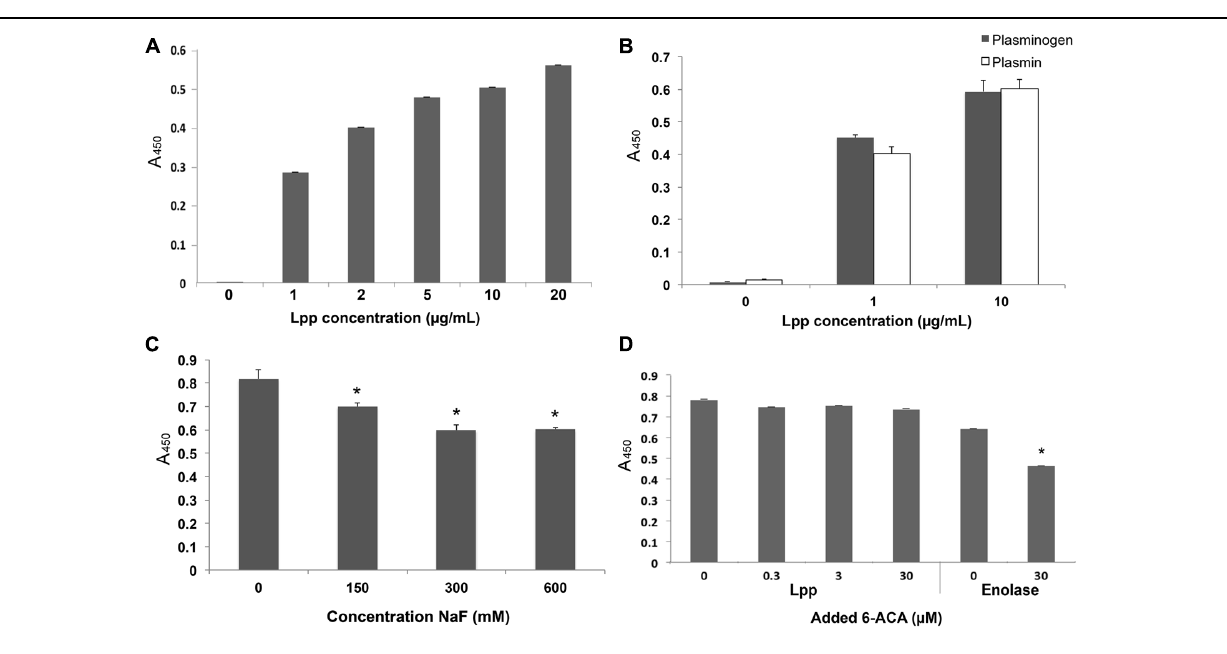
FIGURE 2 | Lpp binds Plg. Enzyme-linked immunosorbent assays (ELISAs) were performed for experiments in which Lpp was allowed to interact with bound Plg (A) or plasmin (B) and values are blanked against those of Lpp interactions with bound BSA. The inhibitors NaF (C) and 6-aminocaproic acid, (ACA) a lysine analog (D) were used to determine the roles of ionic interactions and lysine residues, respectively. ∗ p < 0.05 compared to untreated (no inhibitor)